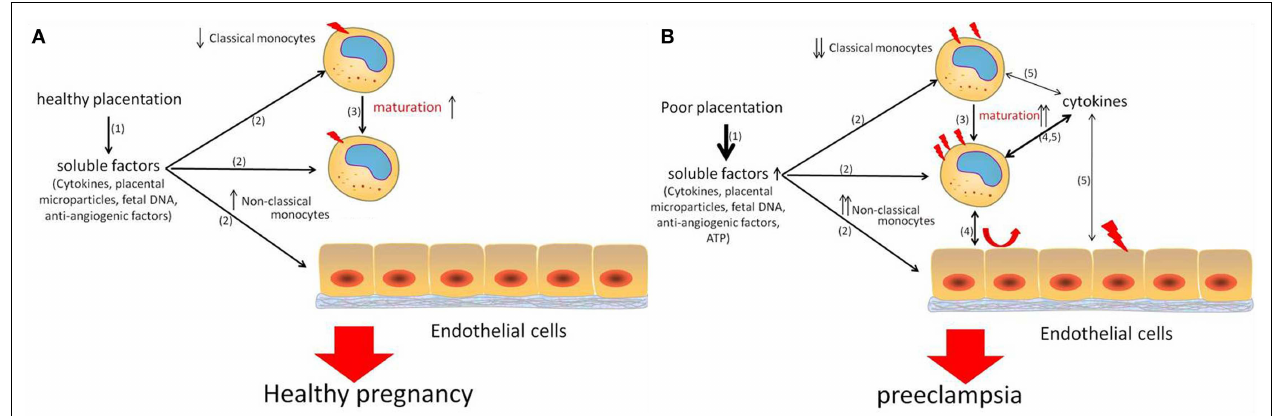
monocytes toward non-classical monocytes (3). Numbers non-classical monocytes are increased and they may play an important role in this inflammatory process, since they are known to produce increased numbers of cytokines upon activation (4).These cytokines further activate the monocytes (5) as well as endothelial cells (5).This vicious circle of activation of monocytes and endothelial cells finally results in the symptoms of pre-eclampsia, such as hypertension and